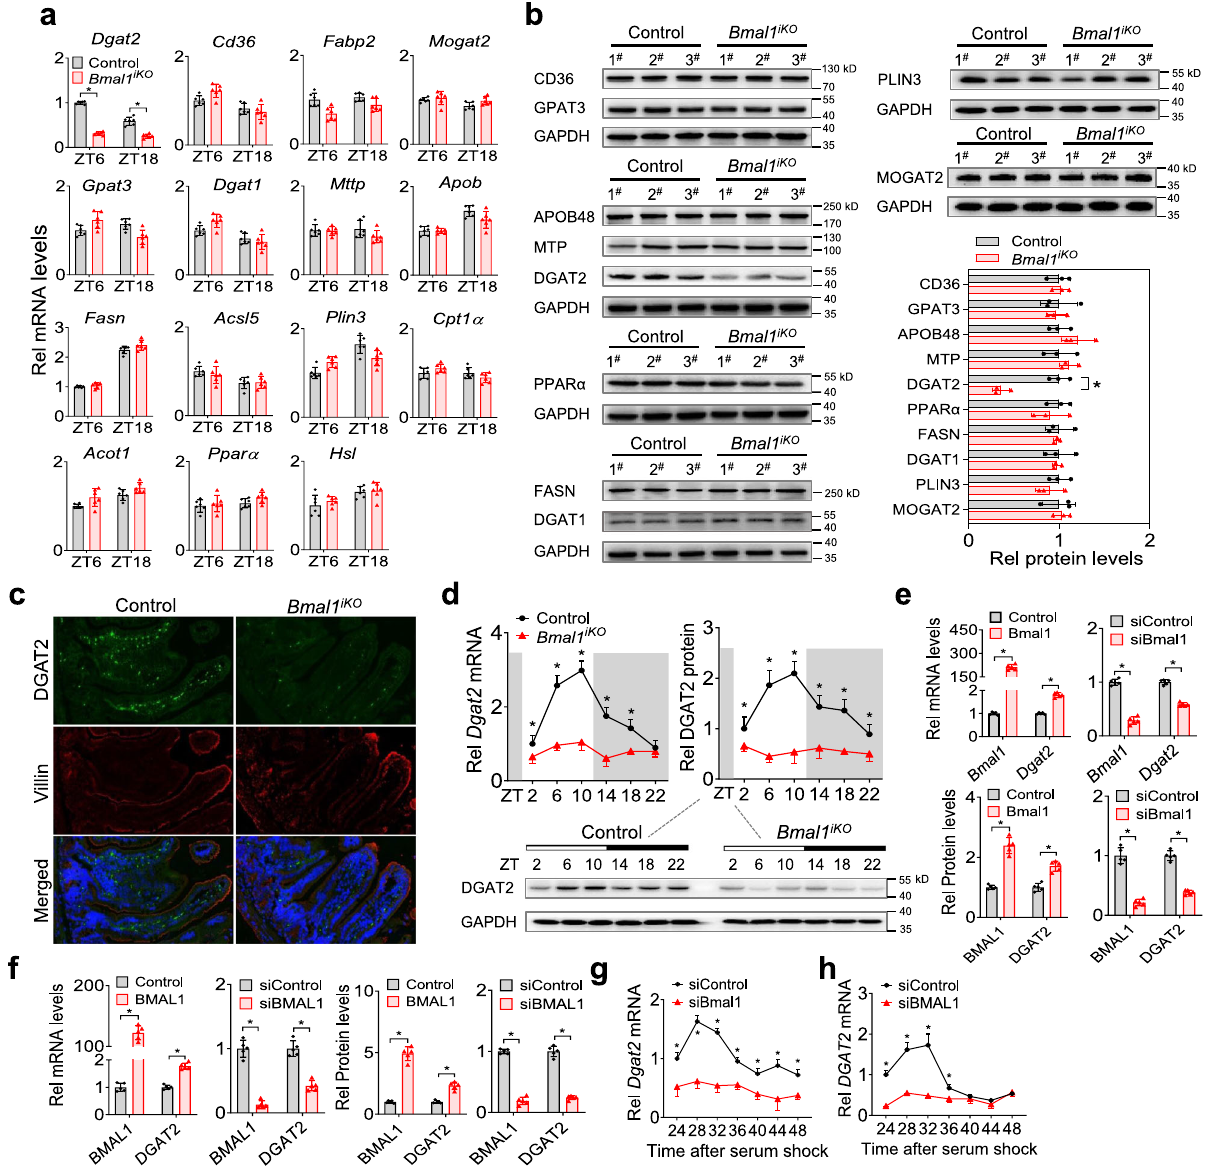
small intestines of Bmal1 iKO and control mice at ZT6 and ZT18. Data are mean ± SD ( n = 6 biologically independent samples). Two-sided t test p